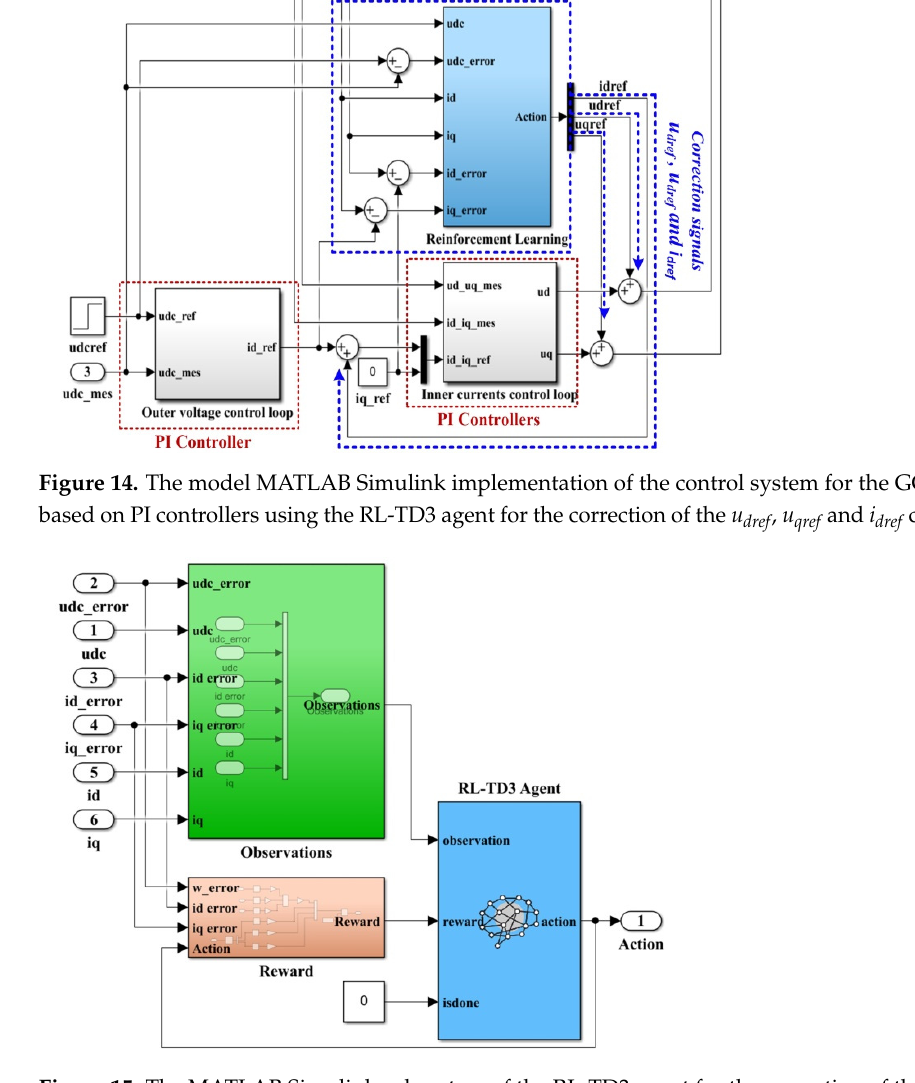
Figure 15. The MATLAB Simulink subsystem of the RL-TD3 agent for the correction of the u dref , u qref and i dref commands.